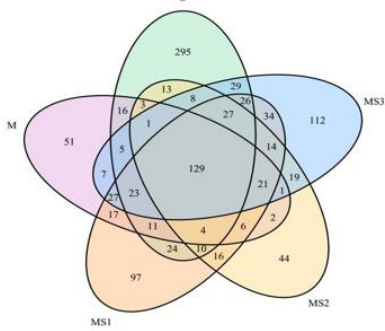
Figure 3. Venn diagram of the common or unique bacterial OTUs of different treatments. S: mono- culture of soybean; M: monoculture of maize; MS1, MS2, and MS3 mean different row ratios of maize and soybean intercropping (1:1, 1:3, and 1:5).